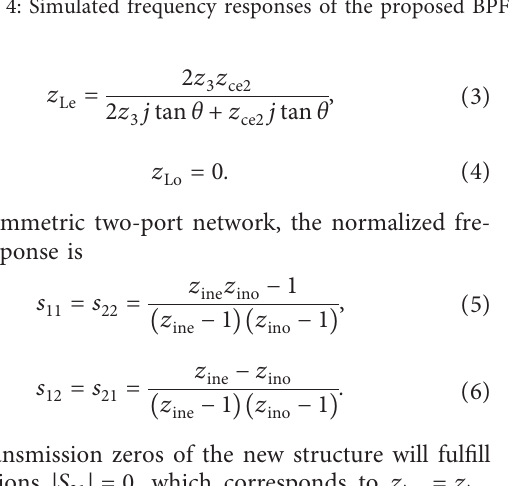
Figure 4: Simulated frequency responses of the proposed BPF with varied impedance parameters. (a) z